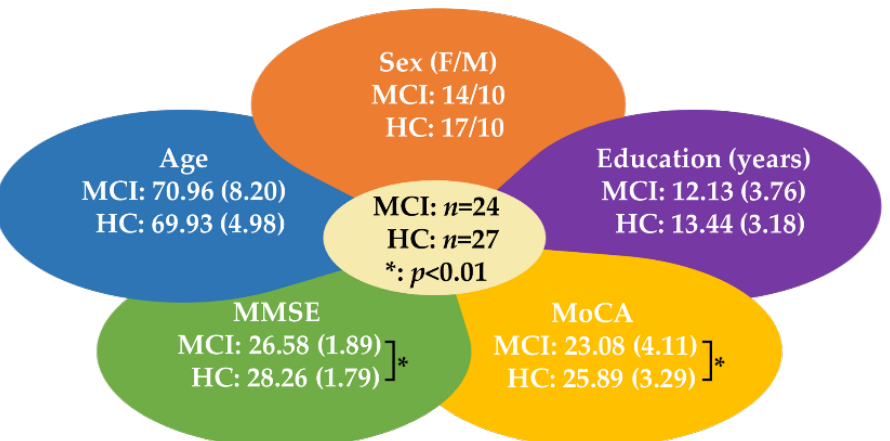
Figure 1. A summary of demographic data and neuropsychological test results of participants. HC = healthy control, MCI = mild cognitive impairment, MMSE = mini-mental state examination, MoCA = Montreal Cognitive Assessment, SD = standard deviation. p -values show the significance of statistical testing of the differences between the two groups. A p -value was considered significant when p -value < 0.01. * denotes p < 0.01.